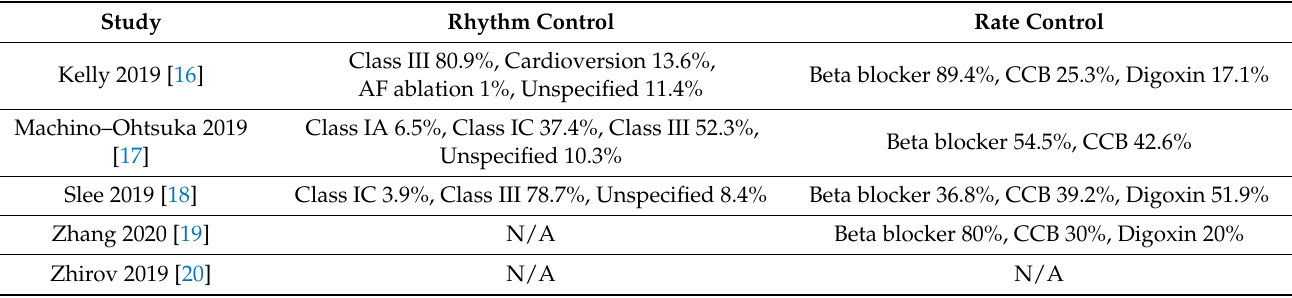
Table 2. Rate and rhythm control